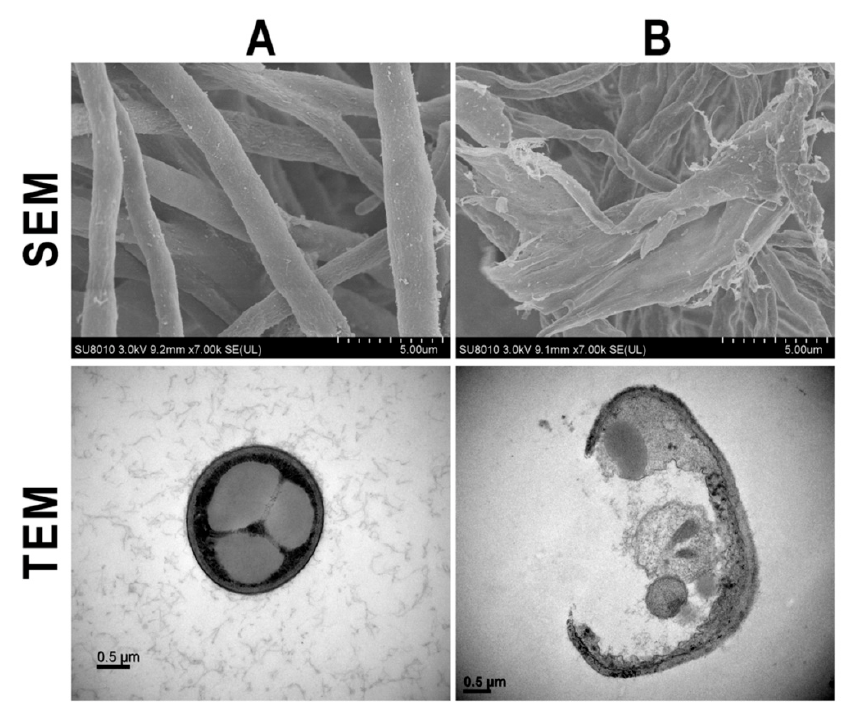
Figure 3. Microscopic images of SEM and TEM of F. graminearum strain PH − 1 in the absence ( A ) and presence ( B ) of the synthesized AgNPs.